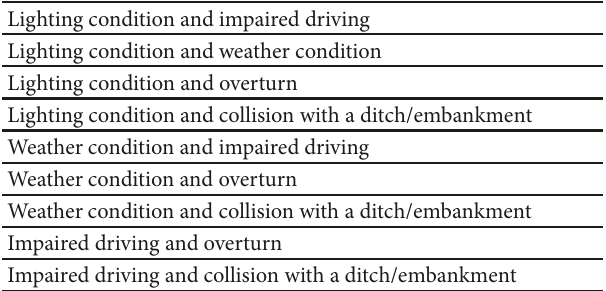
Table 2: List of possible interaction terms. Lighting condition and impaired driving Lighting condition and weather condition Lighting condition and